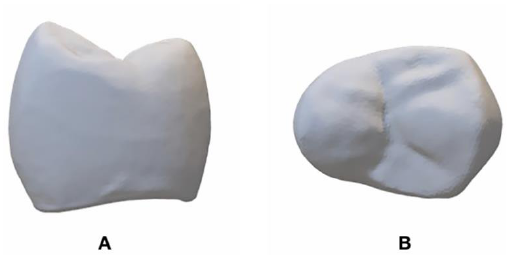
Figure 2. STL 2 file. ( A ), proximal view. ( B ), occlusal view.